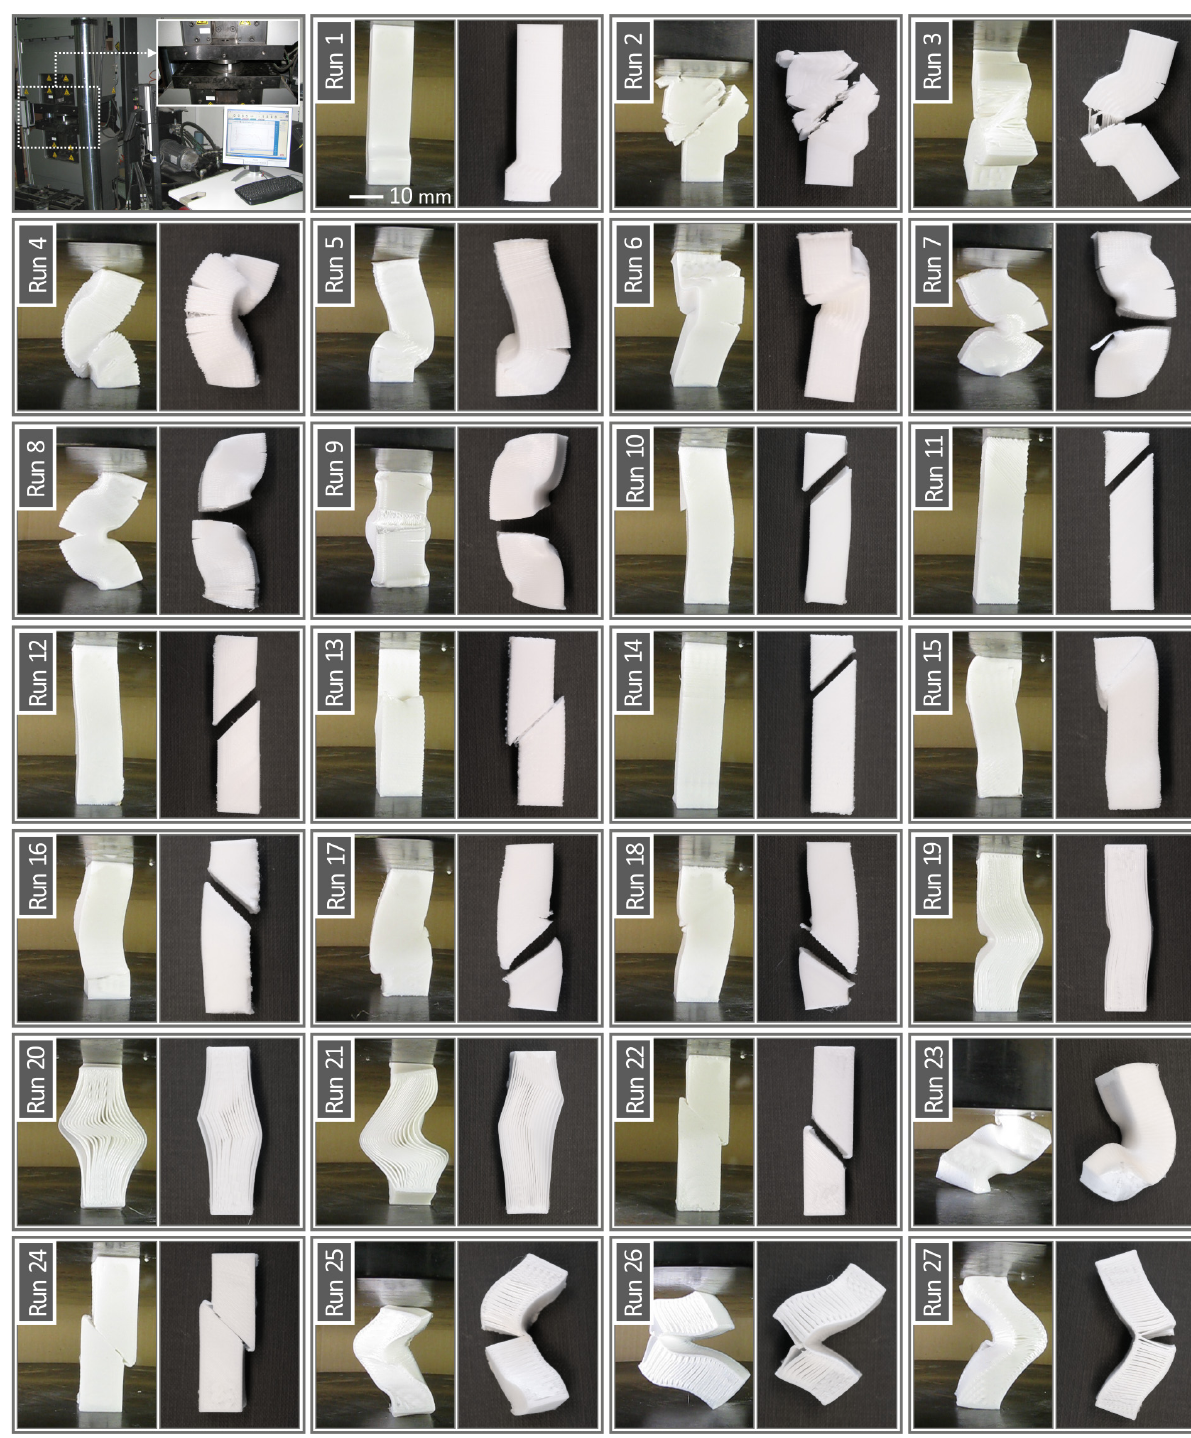
Figure 5. Specimens in the compression test at the failure stage, depicting their different behavior for the various 3D printing sets of settings. the various 3D printing sets of